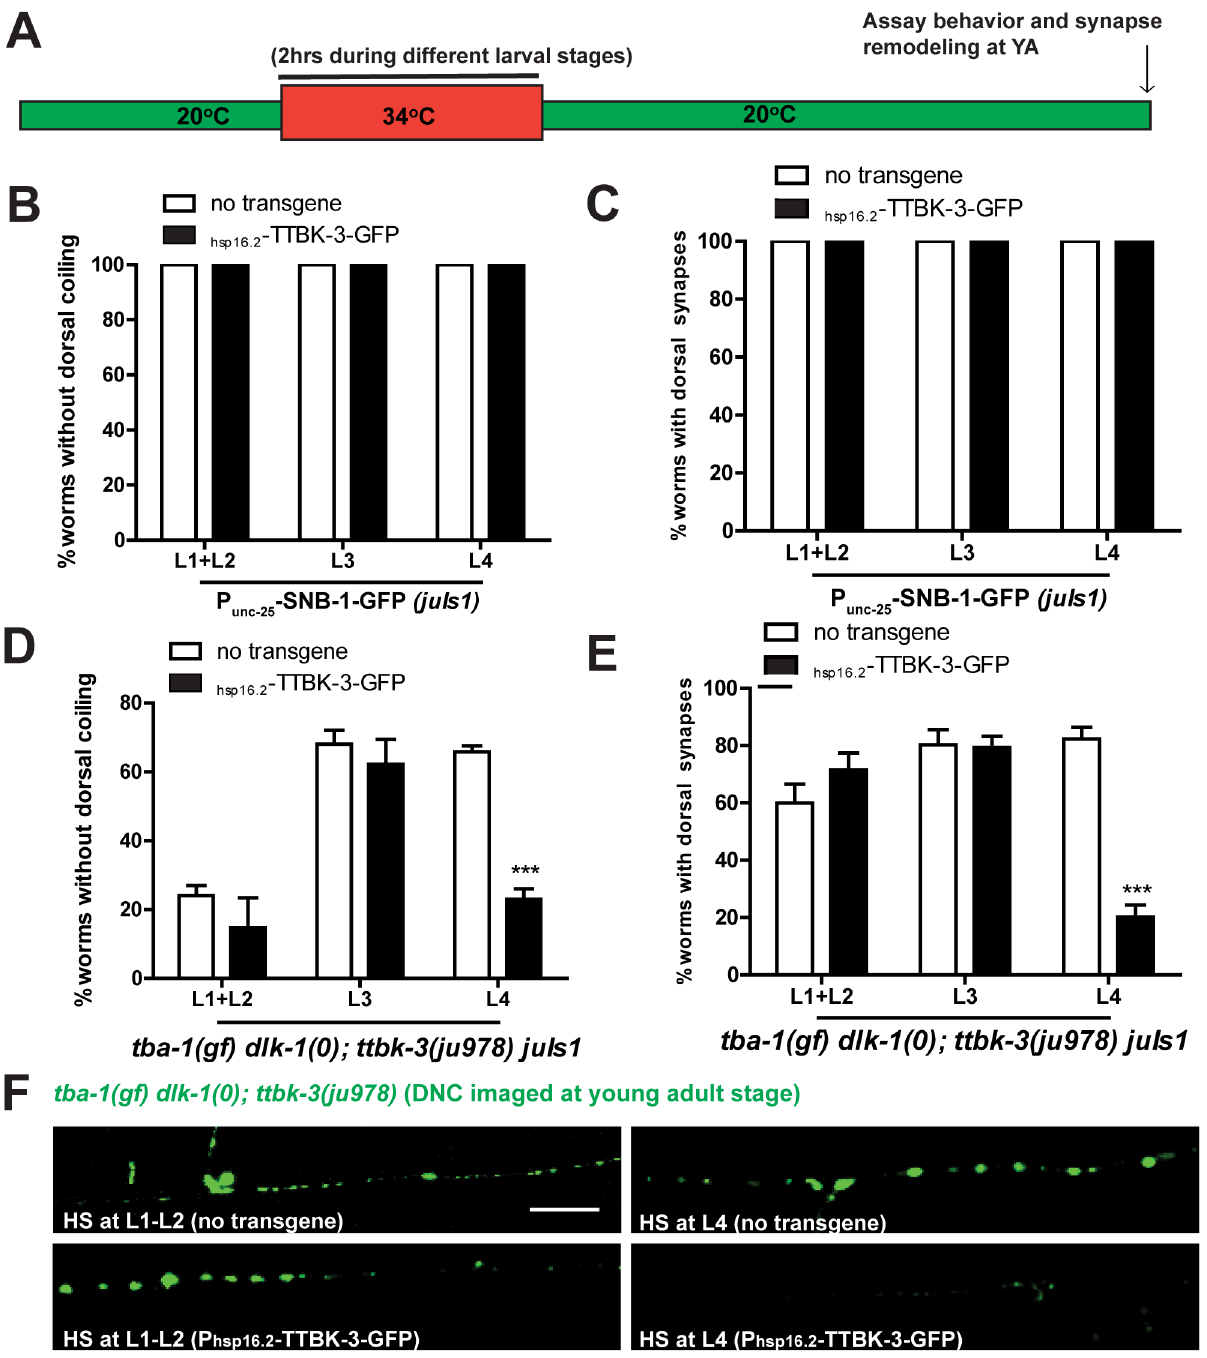
Fig 5. TTBK-3 is required for synapse maintenance during remodeling. (A) Schematic of heat shock assay, where animalsare maintained at 20 ˚ C, undergoa 2hr heat shock duringthe developmental stage being tested, after which they are returnedto 20 ˚ C and assayed at young adult stage. (B-E) Quantificationof % animals with normal behavior (B, D) and synapse remodeling (C, E) followingheat shock at L1-L4 stages. Data collectedfrom 3 independentbiological replicates, with n > 10animalseach, and presentedas mean ± SEM. Statistics- 2-Way ANOVA followedby Bonferroniposttest; *** p < 0.001. (F) Representative images of DD neuronsynapses along the DNC in adult animals imagedusing P unc-25 -SNB-1-GFP ( juIs1 ). Scale bar: 10 μ m.